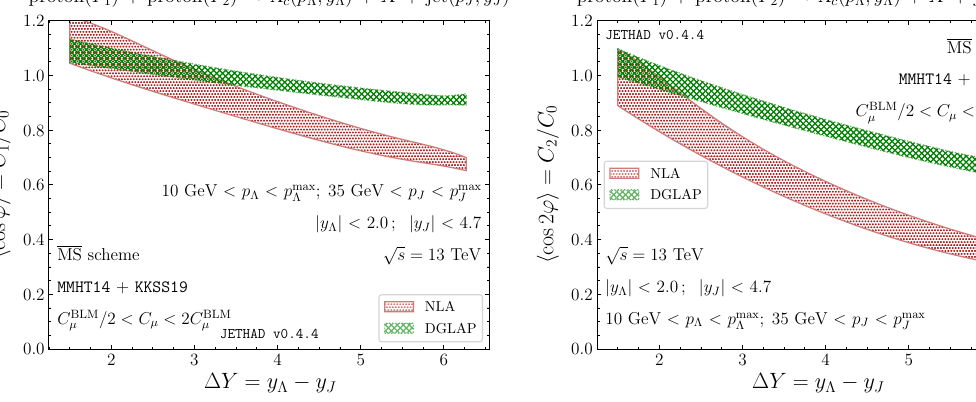
Fig. 6 Behavior of azimuthal-correlation moments, R nm ≡ C n / C m , as functions of (cid:5) Y , in the (cid:2) c plus jet channel, at BLM scales, and for √ s = 13 TeV. Error bands provide with the combined uncertainty com-